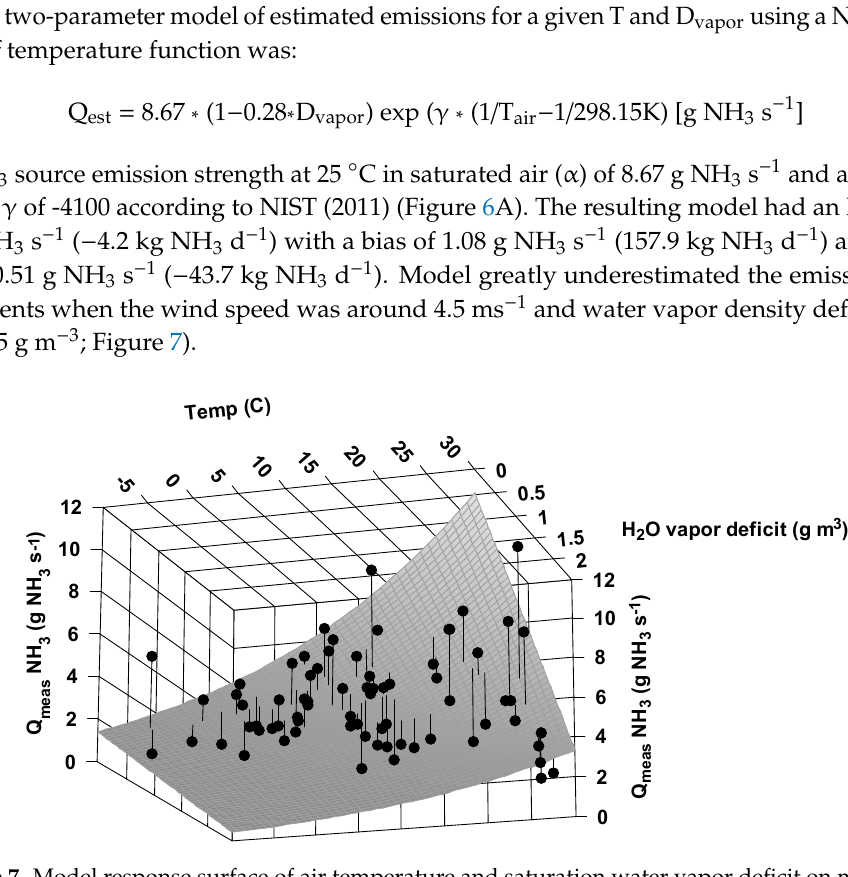
Figure 7. Model response surface of air temperature and saturation water vapor deficit on measured daily NH 3 emissions. Daily emission measurements for representative days are mapped onto the response surface of the model defined by Equation (2).